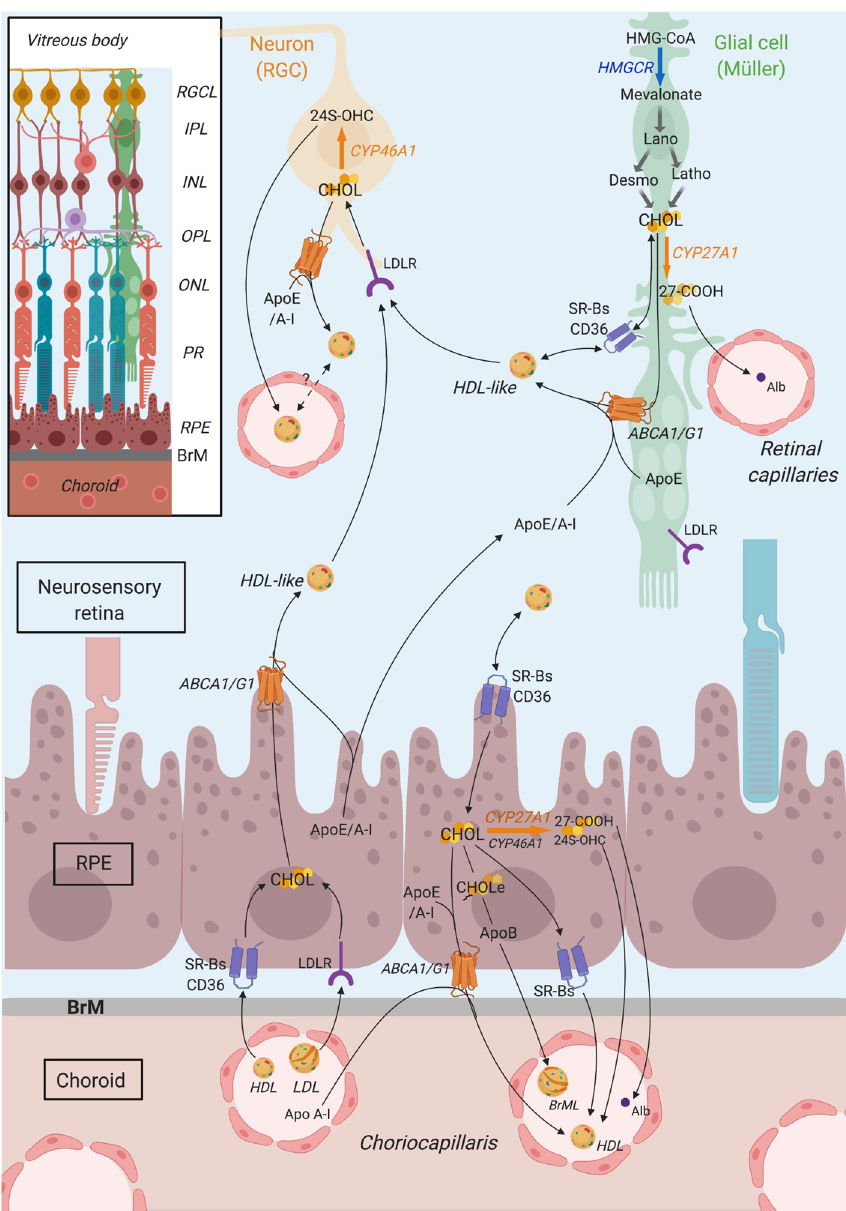
Fig 1. Cholesterol metabolism in the retina. Cholesterol in the retina originates from a local biosynthesis, that likely occurs primarily in glial cells which express HMG-CoA reductase (HMGCR) enzyme, and from the uptake of blood lipoproteins by retinal pigment epithelium (RPE) cells, expressing LDLR family receptors (LDLR) and scavenger receptors (SRBs, CD36). Within the retina, cholesterol is thought to be transported in HDL-like particles, rich in Apo E/AI, secreted by RPE and glial cells, thanks to ABC transporters. HDL-like could be subsequently captured by neighboring cells, especially neurons, or could potentially cross retinal capillaries to reach the systemic circulation and be eliminated. Moreover, RPE cells secrete cholesterol-rich particles, including Bruch’s membrane particles (BrML) at their basal membrane, that reach the circulation via choroidal capillaries. Cholesterol output also involves its conversion into oxysterols, the main two being 24(S)-hydroxycholesterol (24S-OHC) and 3ß-hydroxy-5-cholestenoic acid (27-COOH), produced by CYP46A1 and CYP27A1 enzymes, respectively. CYP46A1 is almost exclusively expressed in retinal ganglion cells (RGCs). CYP27A1 is more ubiquitously expressed in the retina, including likely photoreceptors and Mu¨ller cells. CHOL : cholesterol , Desmo : Desmosterol , Latho : Lathosterol , CHOLe : Cholesterol esters , Alb : Albumin . RGCL : RGC layer , IPL : Inner plexiform layer , INL : Inner nuclear layer , OPL : Outer plexiform layer , ONL : Outer nuclear layer , PR : Photoreceptors . BrM : Bruch’s membrane . Created in Biorender.com. and reprinted under a CC BY 4.0 license, with permission from Biorender, original copyright